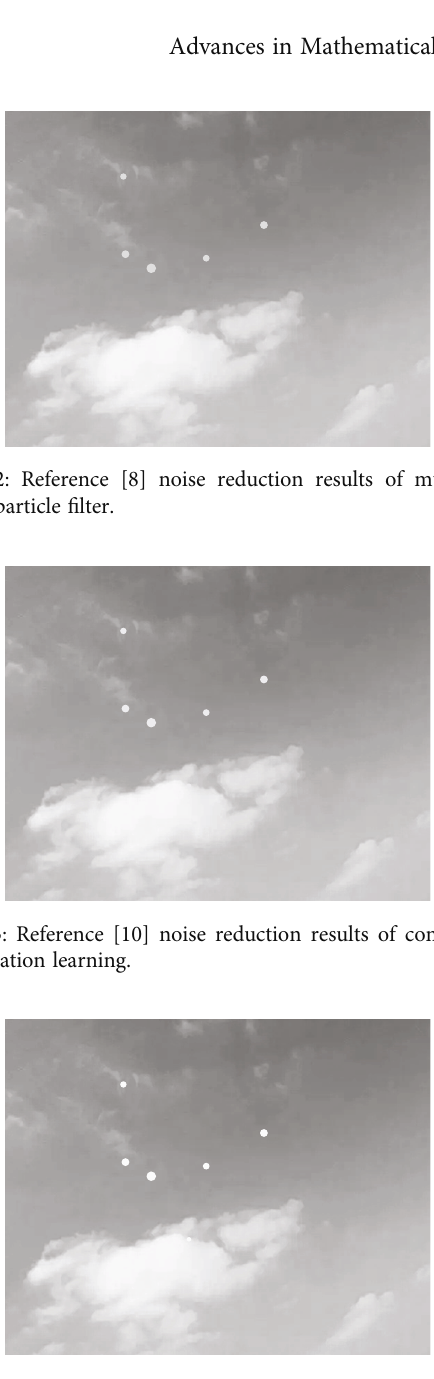
Figure 4: The noise reduction results of the mean shift fi lter proposed in this